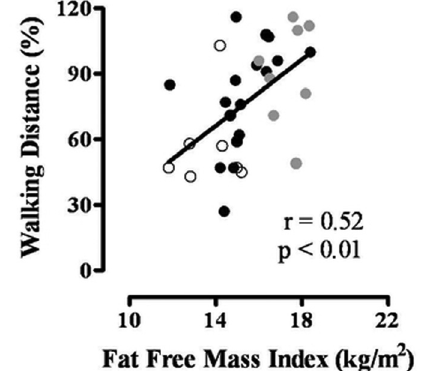
Figure 1 - Association between fat-free mass index (FFMI) and exercise capacity. Gray circles represent patients who are overweight/obese; black circles represent patients who are of normal weight; white circles represent patients who are